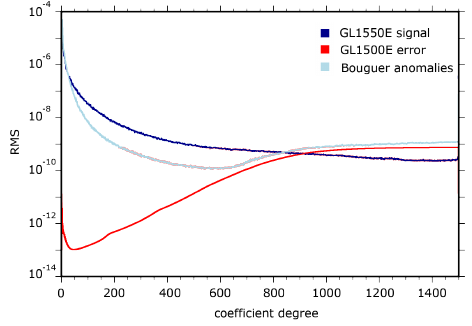
Figure 1. Power spectra of the GRAIL gravity field model GL1500E, the associated uncertainties of the coefficients, and the Bouguer anomalies, calculated with a crustal density of 2550 kg m −